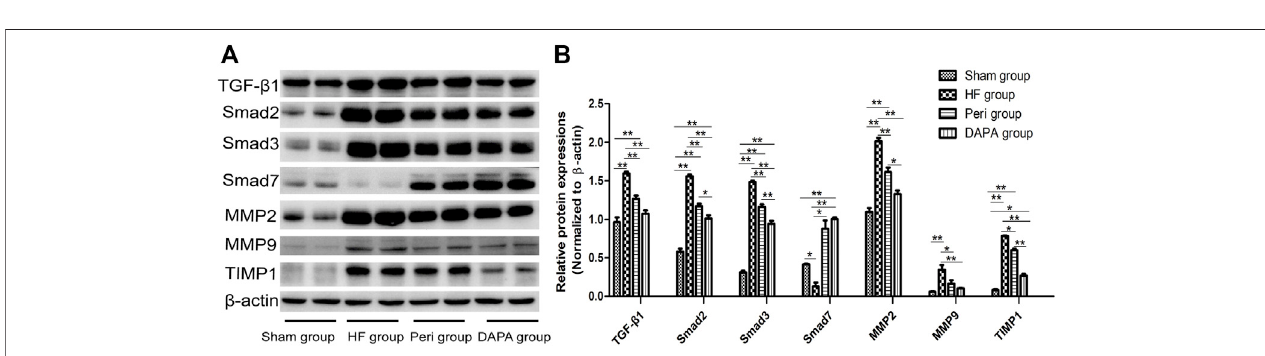
FIGURE 4 | Effect of DAPA on myocardial fi brosis. (A) Western blotting analysis for the expressions of collagen I, collagen III, α -SMA, and CTGF. (B) Relative expression at the protein level was determined, and β -actin was adopted as the loading control. Data were expressed as the mean ± SD. * p < 0.05; ** p < 0.01.